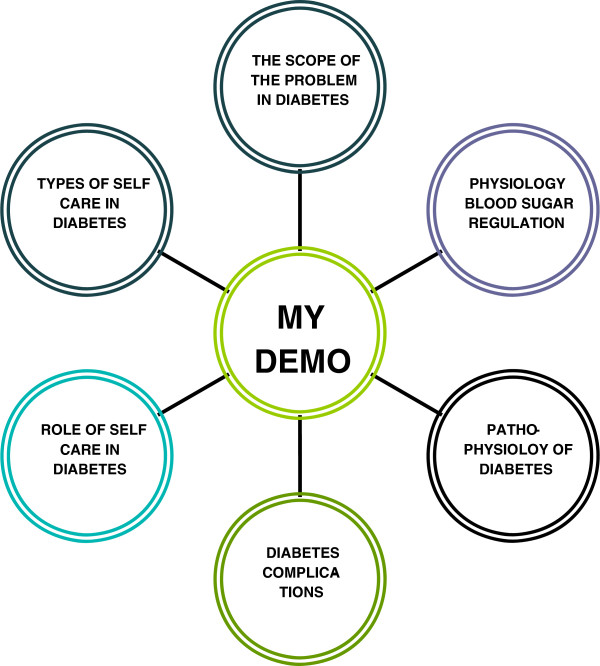
The important aspects highlighted in the MY DEMO.